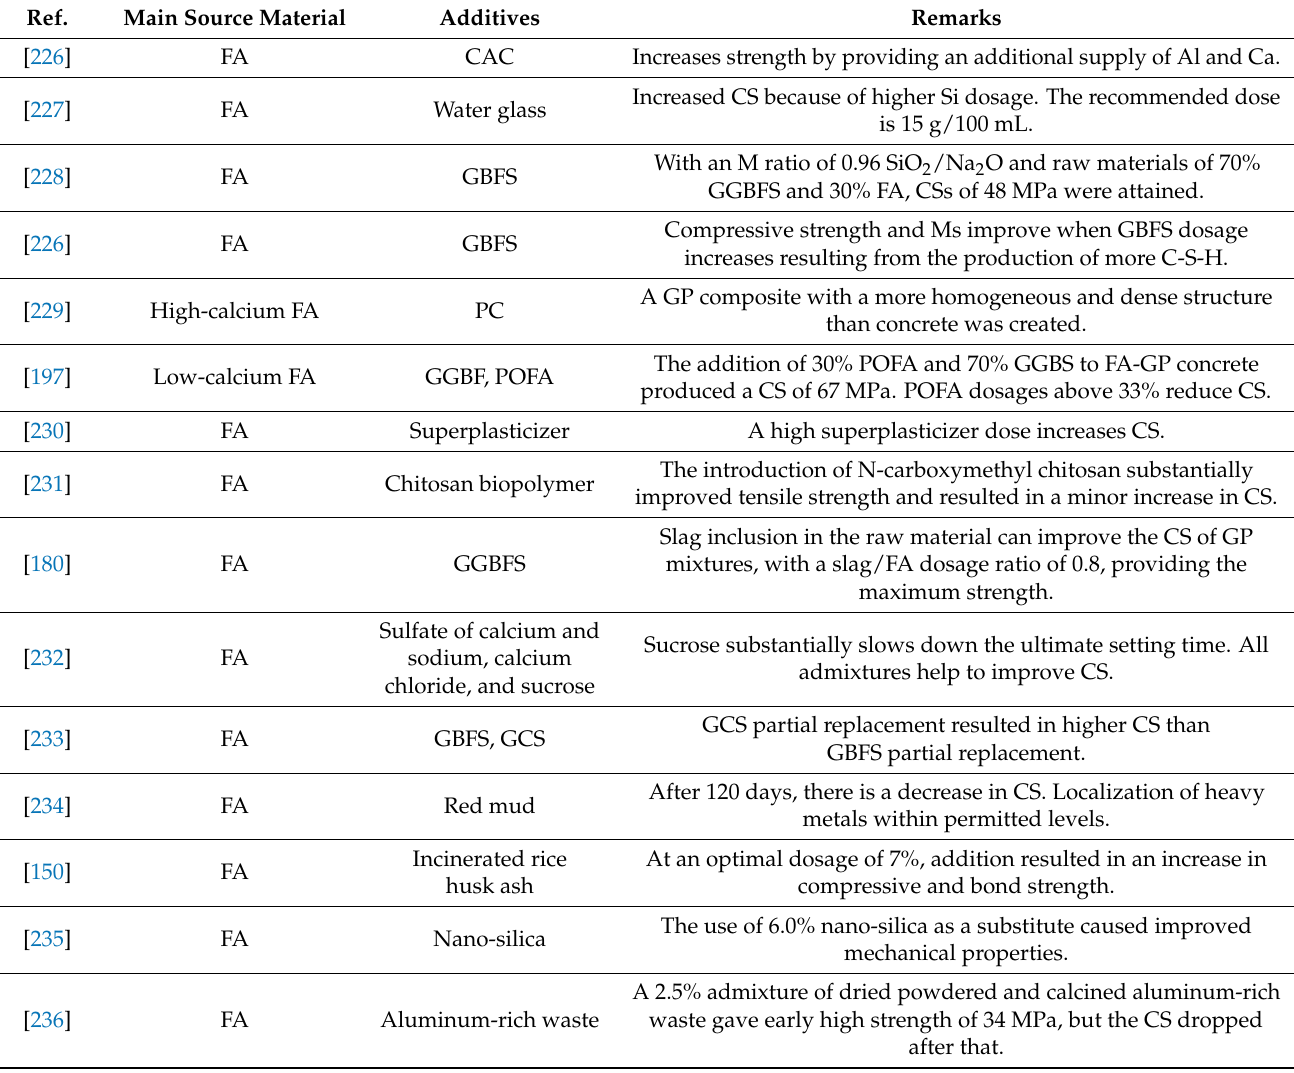
Table 4. Effect of different additives on FA-GP concrete CS.